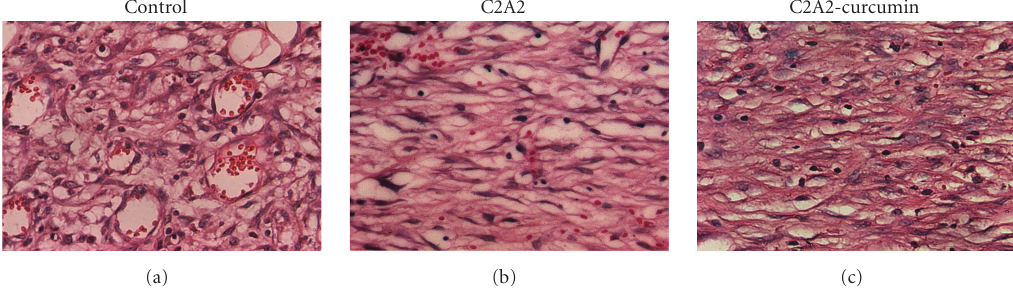
Figure 8: The H&E stained sections of twelve-day postwounding (40 × ).